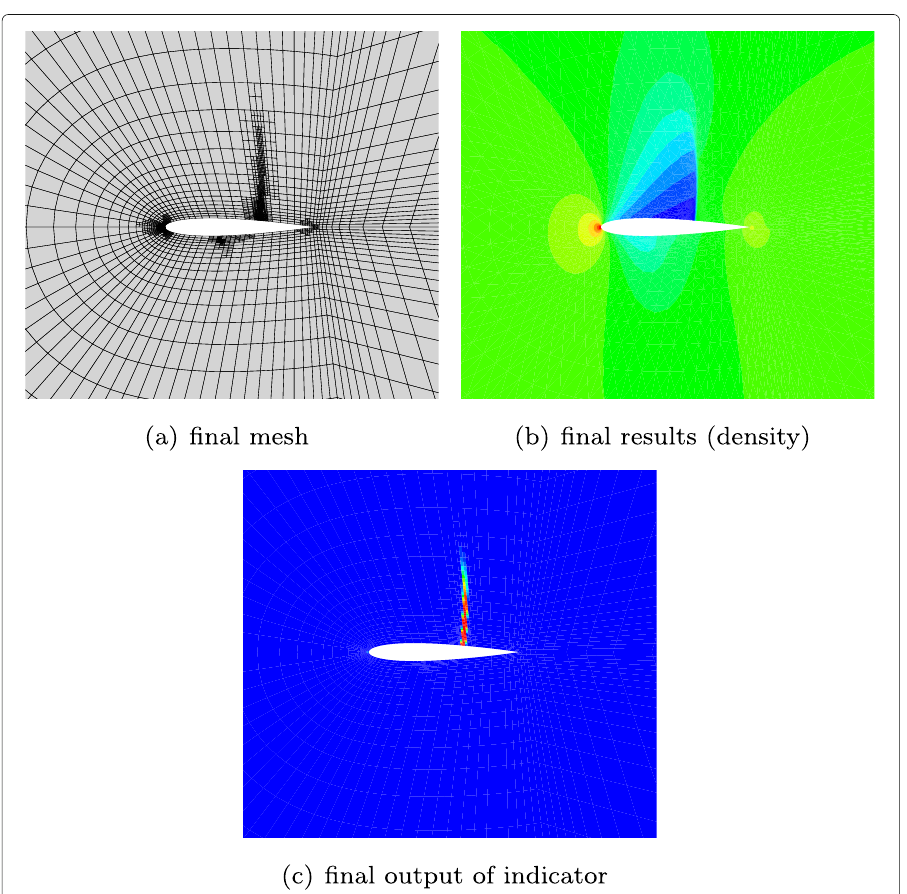
Fig. 19 Final results of the transonic flow around the NACA0012 airfoil after 3 times of mesh refinement with θ =